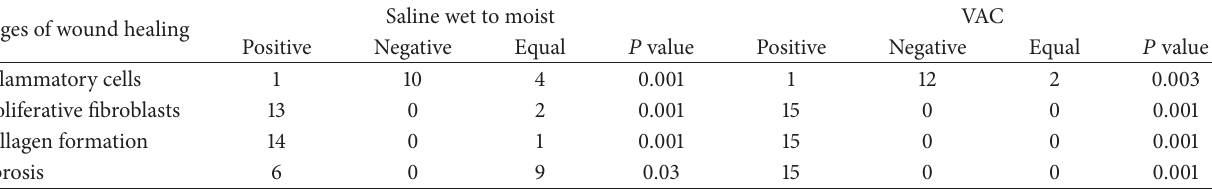
Table 4: Comparison of histological parameters from day 0 to day 8 by Wilcoxon signed ranks